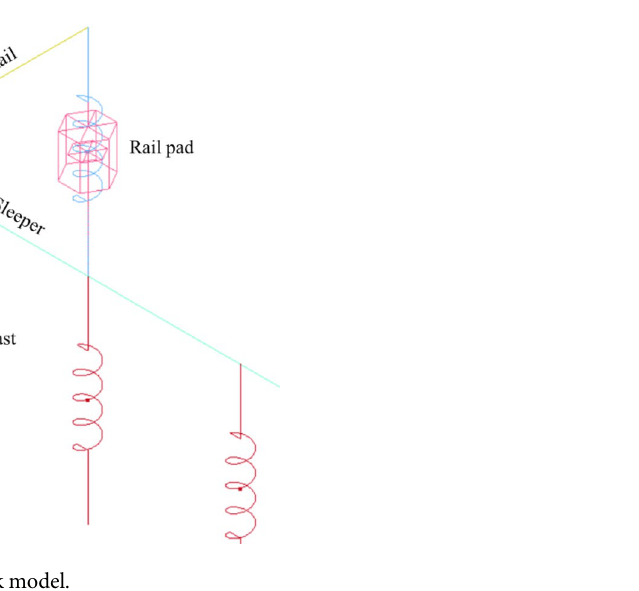
Figure 2. Detailed ballasted track